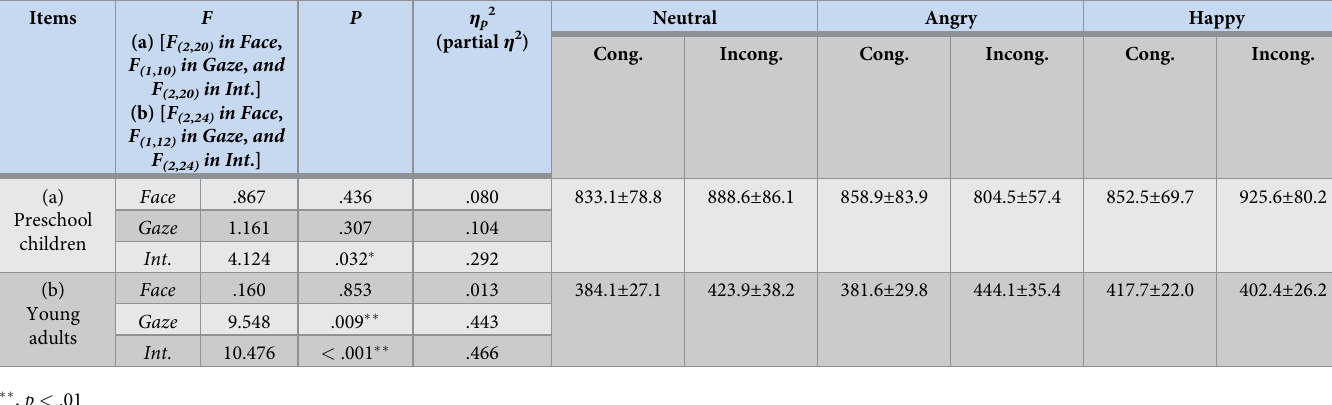
Table 6. Reaction times (in ms) and statistics under all experimental conditions for (a) preschoolers and (b) young adults.